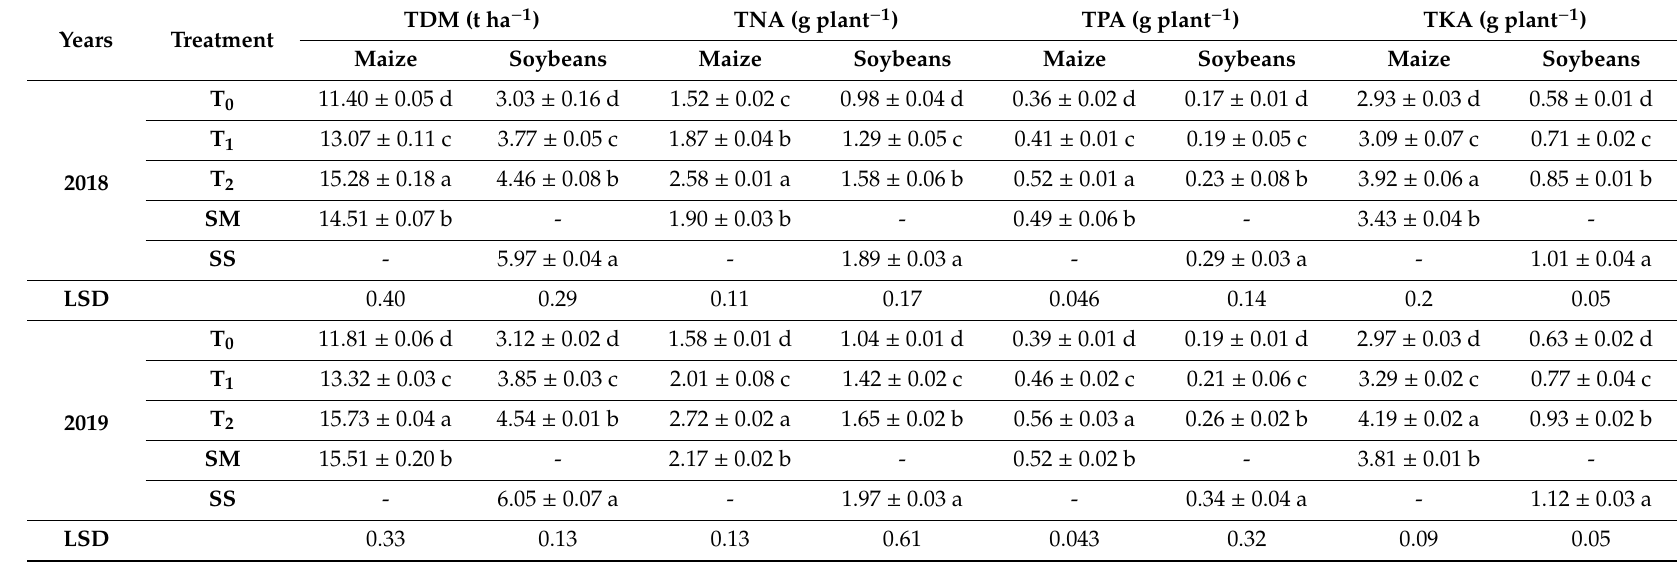
Table 1. E ff ect of di ff erent potassium application on a dry matter (TDM), total nitrogen accumulation (TNA), total phosphorus accumulation and total potassium accumulation (TKA) of maize and soybeans during